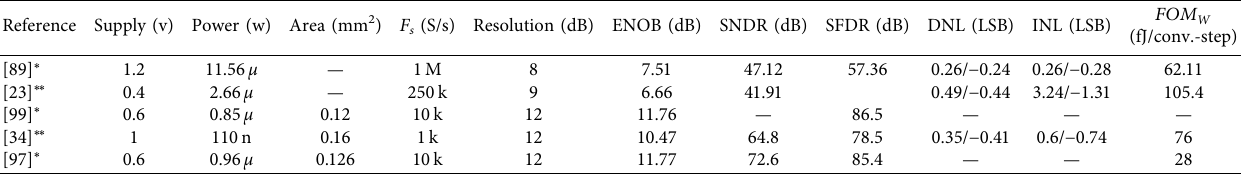
Table 5: Summary of the recently published SAR ADC performance parameters in 130nm process.